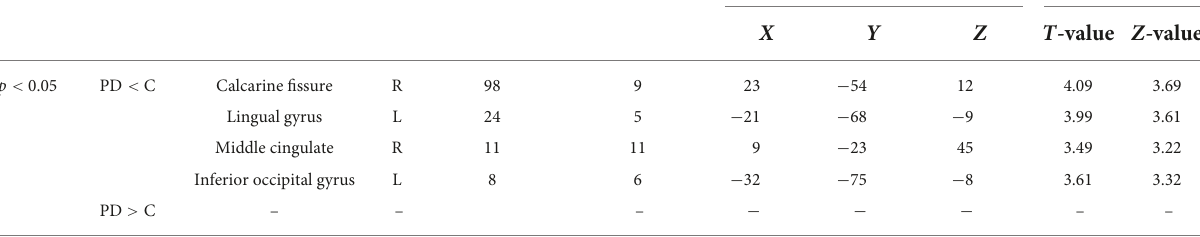
TABLE 3 White matter alterations detected by VBM. P -value Contrast Anatomical region L/R Size (Voxels) No. of clusters